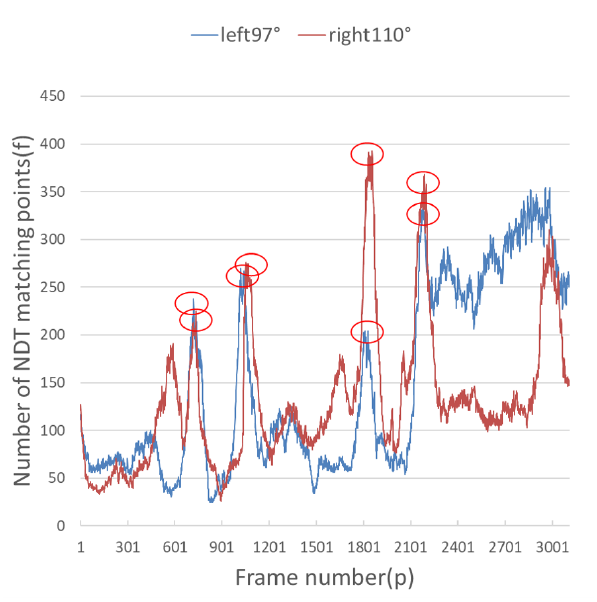
Figure 10. Number of valid points on the left and right during NDT